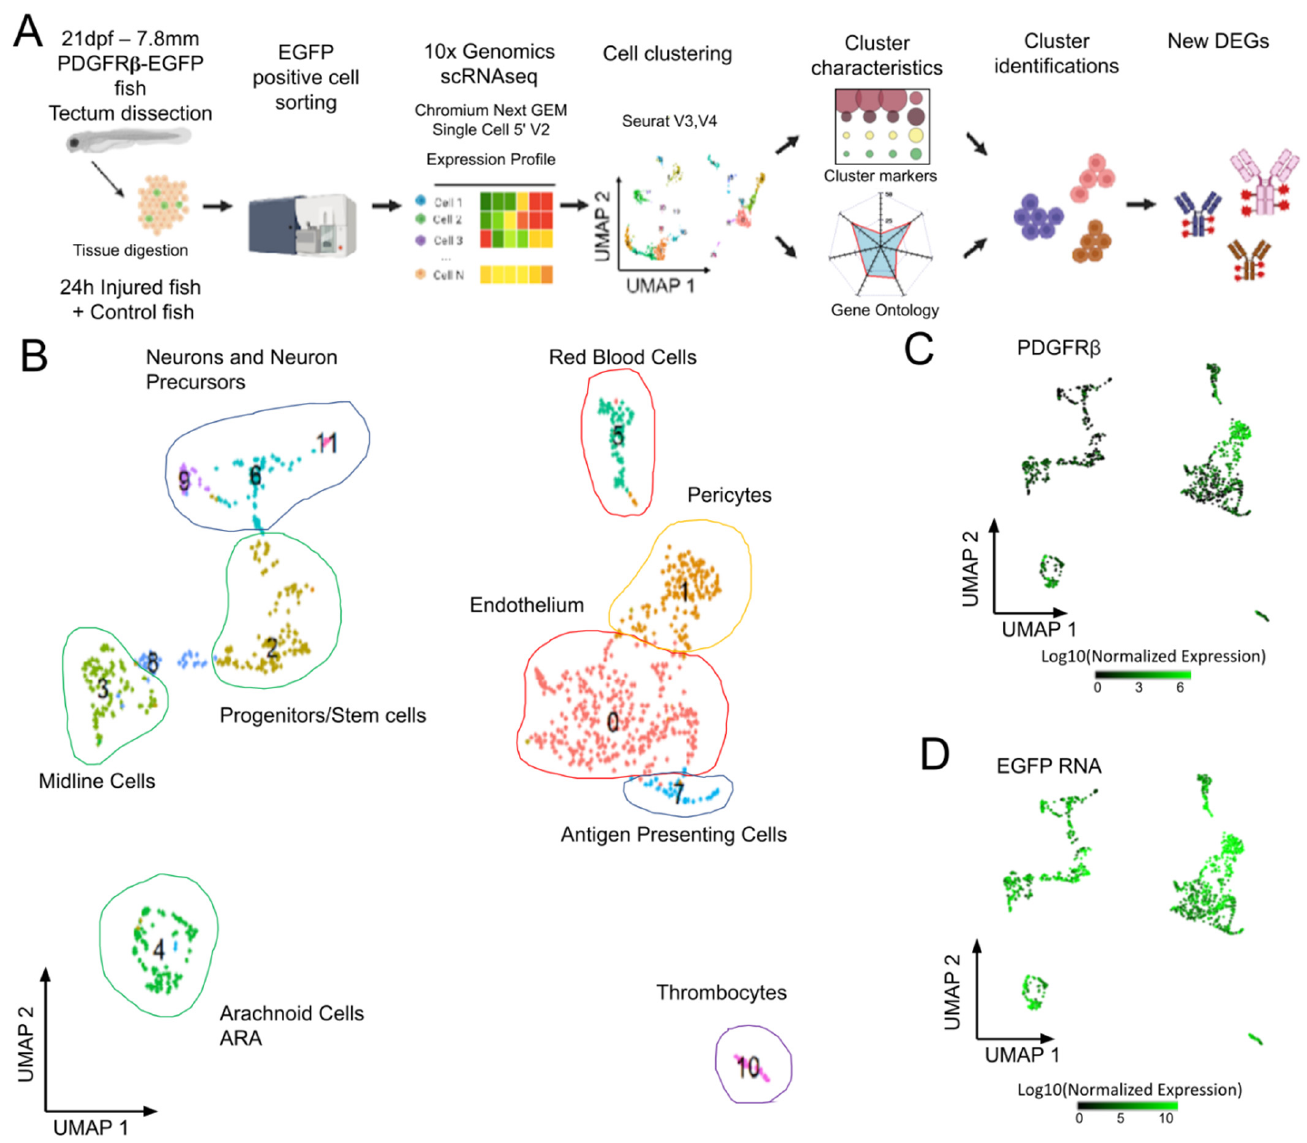
Figure 2. Analysis of scRNAseq data highlights cell heterogeneity of GFP positive cells from dis- sected tecta of PDGFR β -gal4:UAS-EGFP juveniles. ( A ). Experimental workflow for the collection and isolation of OT cells. ( B ). Uniform manifold approximation and projection (UMAP) showing cell populations from control 21 dpf juveniles. The projection was performed with the 30 first principal component analysis of gene expression. Each point represents a single cell with a colour indicating its membership to a cluster. 0: KDRL- Endothelium; 1: NDUFA.4L2A-Pericyte; 2: RPS2-Progenitors, Stem cells; 3: ZIC4- Midline Cells; 4: AQP1A.1-Arachnoid Cells; 5: HBAA1-Red Blood Cells; 6: ELAVL4- Neurogenic Precursors; 7: CD74A-Antigen Presenting Cells; 8: Uncharacterized; 9: NEUROD1- Neurons and Precursors; 10: THBS1B- Thrombocytes; 11: HPCA- Neurons. ( C ). Fea- tureplot highlighting PDGFR β transcript levels in cells. ( D ). Featureplot of GFP transcript levels. PDGFR β expression is correlated to GFP showing that most GFP+ cells express PDGFR β